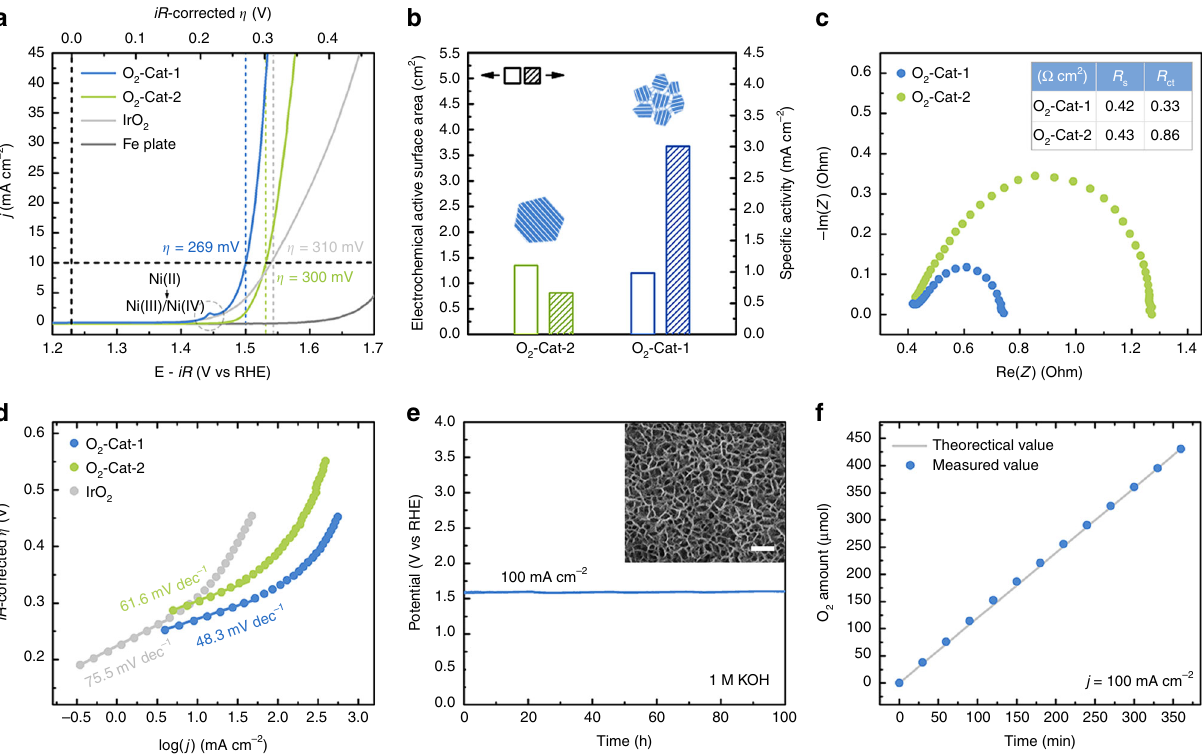
Fig. 4 Electrocatalytic properties of the electrodes for OER. a Polarization curves of O 2 -Cat-1, O 2 -Cat-2, IrO 2 and iron plate in 1 M KOH electrolyte with 85% iR -compensations. The current densities are normalized by the geometric area. b Comparison of electrochemical active surface areas (ECSAs) and ECSA-normalized speci fi c activities of O 2 -Cat-1 and O 2 -Cat-2 (evaluated at an overpotential of 300 mV). Inset: the schematic illustration for the microstructures of the individual LDH nanosheet in the materials. c Comparison of electrochemical impedance spectra between O 2 -Cat-1 and O 2 -Cat-2. d Tafel plots for OER over O 2 -Cat-1, O 2 -Cat-2 and IrO 2 . e Chronopotentiometric curve of O 2 -Cat-1 in 1 M KOH electrolyte at a current density of 100 mA cm − 2 . Inset: SEM image of